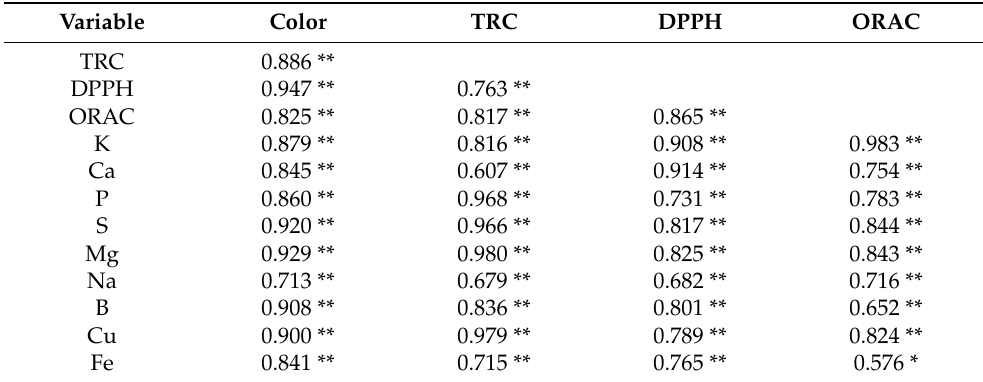
Table 5. Correlation matrix (Pearson’s correlation coefficients) of color, antioxidant and macroelement parameters in Hungarian honeys.